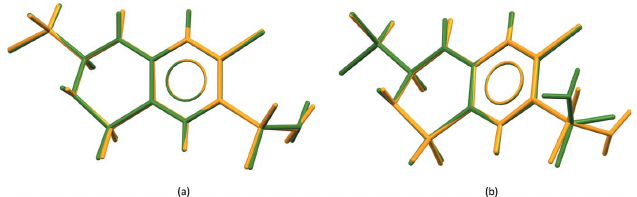
Figure 2 Superposition of the S -molecule in racemic TCMZ (yellow) with the